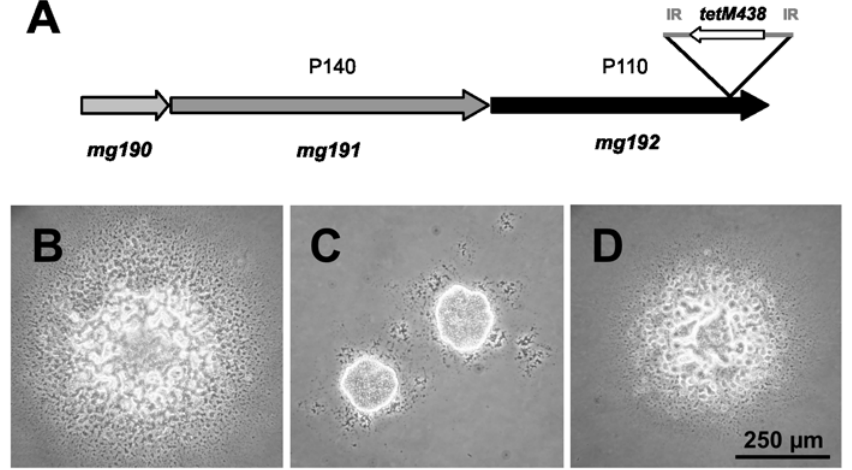
Figure 1. Altered colony morphology of the T192 mutant. (A) Scheme showing the insertion of the MTn TetM438 minitransposon in the mg192 coding region of the T192 mutant. Colony morphology of cells from the WT strain (B), the T192 mutant (C) and the T192C mutant (D) developed in soft agar. Cells from the WT strain and the complemented T192 mutant develop colonies with a disperse morphology while the T192 cells form colonies with a compact morphology indicative of motility deficiencies. IR, inverted repeat.